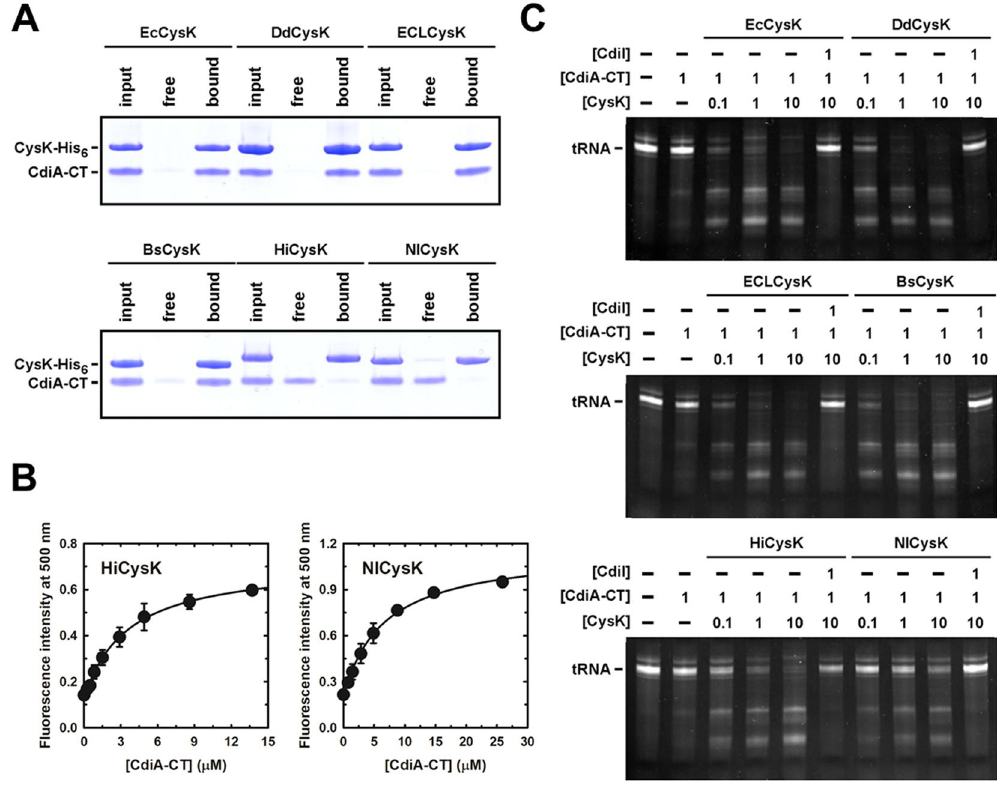
Figure 6. In vitro activation of CdiA-CT by heterologous CysK. ( A ) Affinity purification of CysK:CdiA-CT complexes. His 6 -tagged CysK proteins from the indicated species were incubated with untagged CdiA-CT and the mixture subjected to Ni 2 + -affinity chromatography. The initial protein mixture (input), the column flow- through fraction (free) and the elution fraction (bound) were analyzed by SDS-PAGE. ( B ) Determination of the CysK:CdiA-CT dissociation constants. HiCysK (300 nM) and NlCysK (860 nM) were titrated with increasing concentrations of CdiA-CT, and fluorescence emission at 500 nm monitored after 20 min. Eq. 1 was fitted to the binding data to obtain K d = 3.3 ± 0.3 µ M for HiCysK and K d = 6.4 ± 0.6 µ M for NlCysK. ( C ) Heterologous CysK promotes CdiA-CT nuclease activity. Proteins were incubated at the indicated concentrations ( µ M) for 20 min prior to the addition of RNA substrate. Reactions were quenched after 1 h at 37 °C, then run on 8 M urea- polyacrylamide gels and visualized by ethidium bromide staining. The migration position of full-length tRNA is